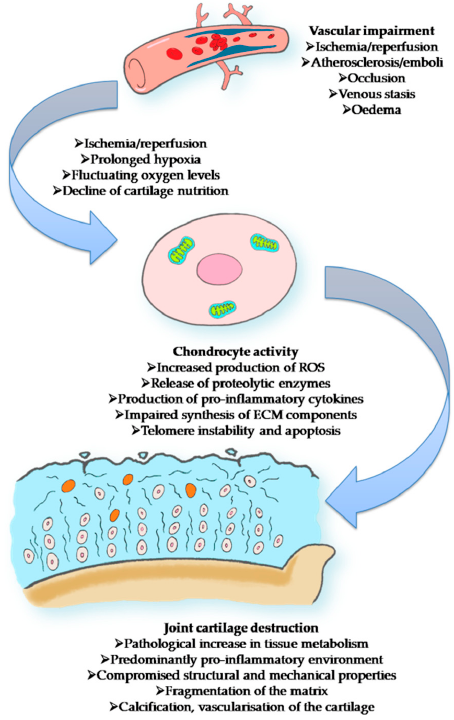
Figure 3. Vascular impairment leading to a disruption in chondrocyte activity and the subsequent destruction of joint cartilage. It has been shown that decreased blood flow results in poor nutrition, as well as the disruption of chondrocyte function and fluctuating oxygen levels promoting a pathological augmentation in metabolic activity [11,12]. In addition, in cases of prolonged hypoxia, chondrocytes release high amounts of proinflammatory cytokines and reactive oxygen species (ROS), which contribute to the development of a proinflammatory microenvironment [13]. Chondrocyte telomere instability as well as apoptosis may also be bolstered by the presence of ROS [14]. Moreover, oxidative stress induces a reduction of extracellular matrix (ECM) components by chondrocytes, leading to an alteration of cartilage structure and the subsequent decline of the tissue’s mechanical properties, with the appearance of fissures and fragmentation